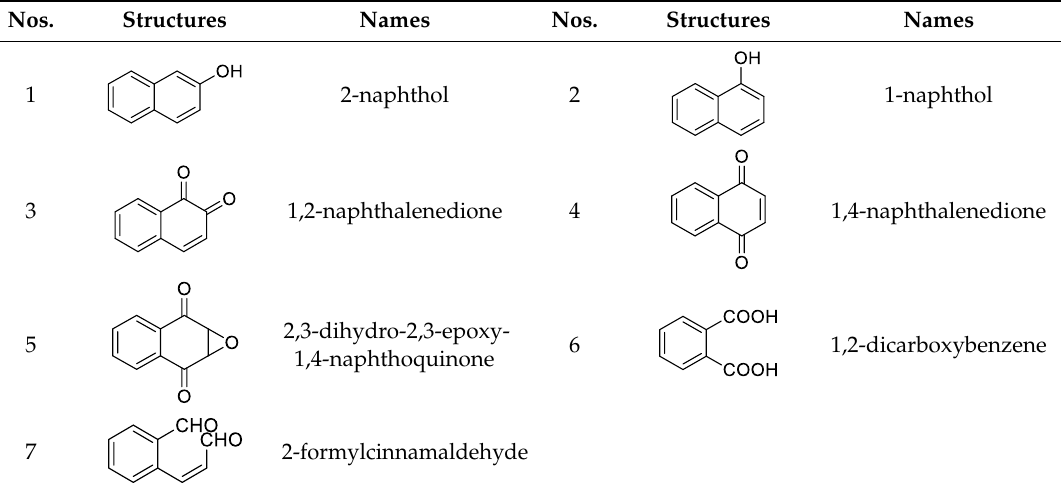
Table 1. Main reaction intermediates identified by gas chromatography-mass spectrometer (GC-MS). Nos. Structures Names